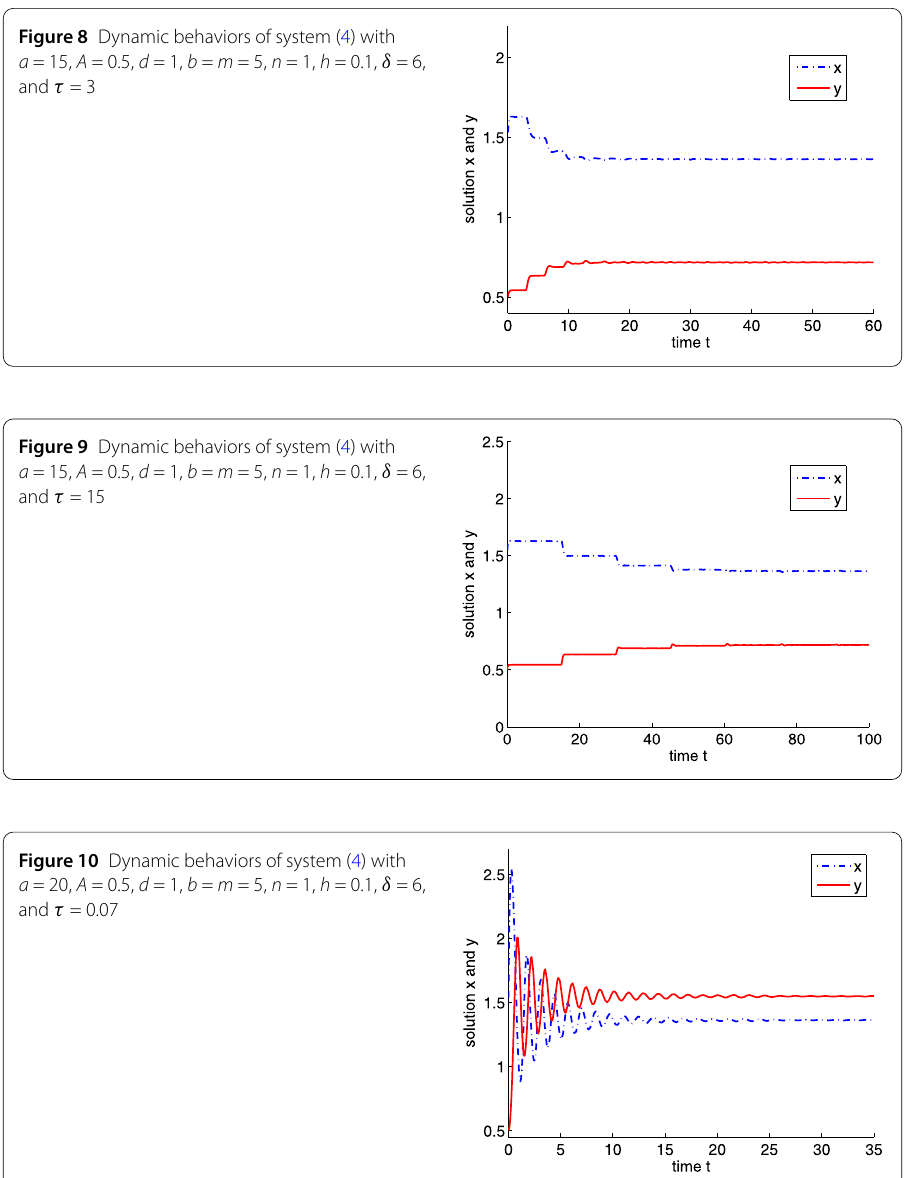
Figure 8 Dynamic behaviors of system (4) with a = 15, A = 0.5, d = 1, b = m = 5, n = 1, h = 0.1, δ = 6,